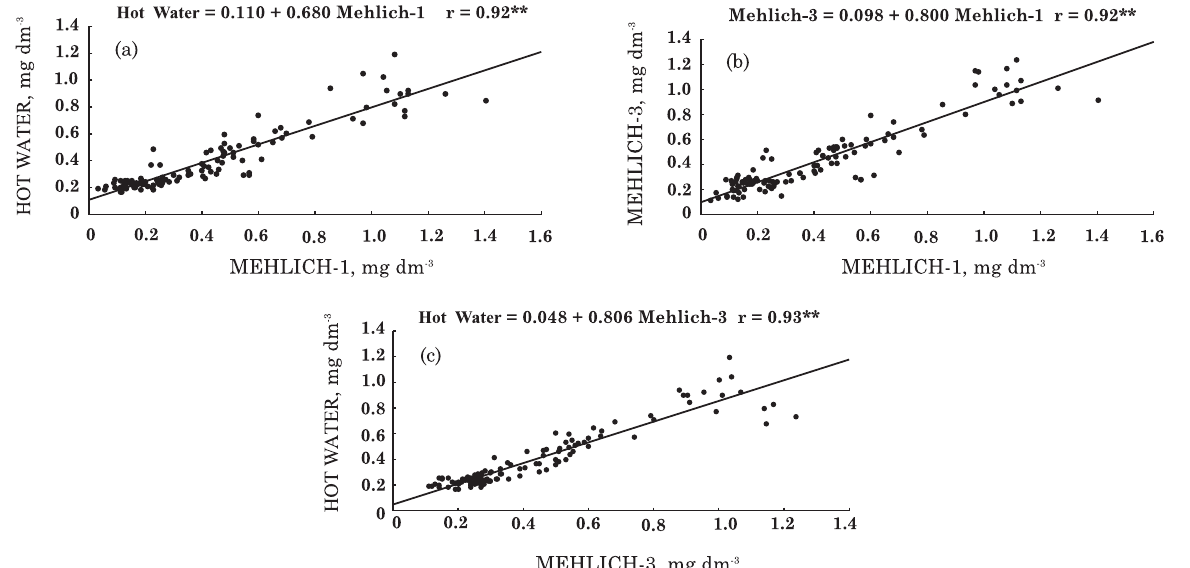
Figure 2. Correlation between results of different B extractors: (a) Hot Water and Mehlich-1; (b) Mehlich-3 and Mehlich-1; (c) Hot Water and Mehlich-3.